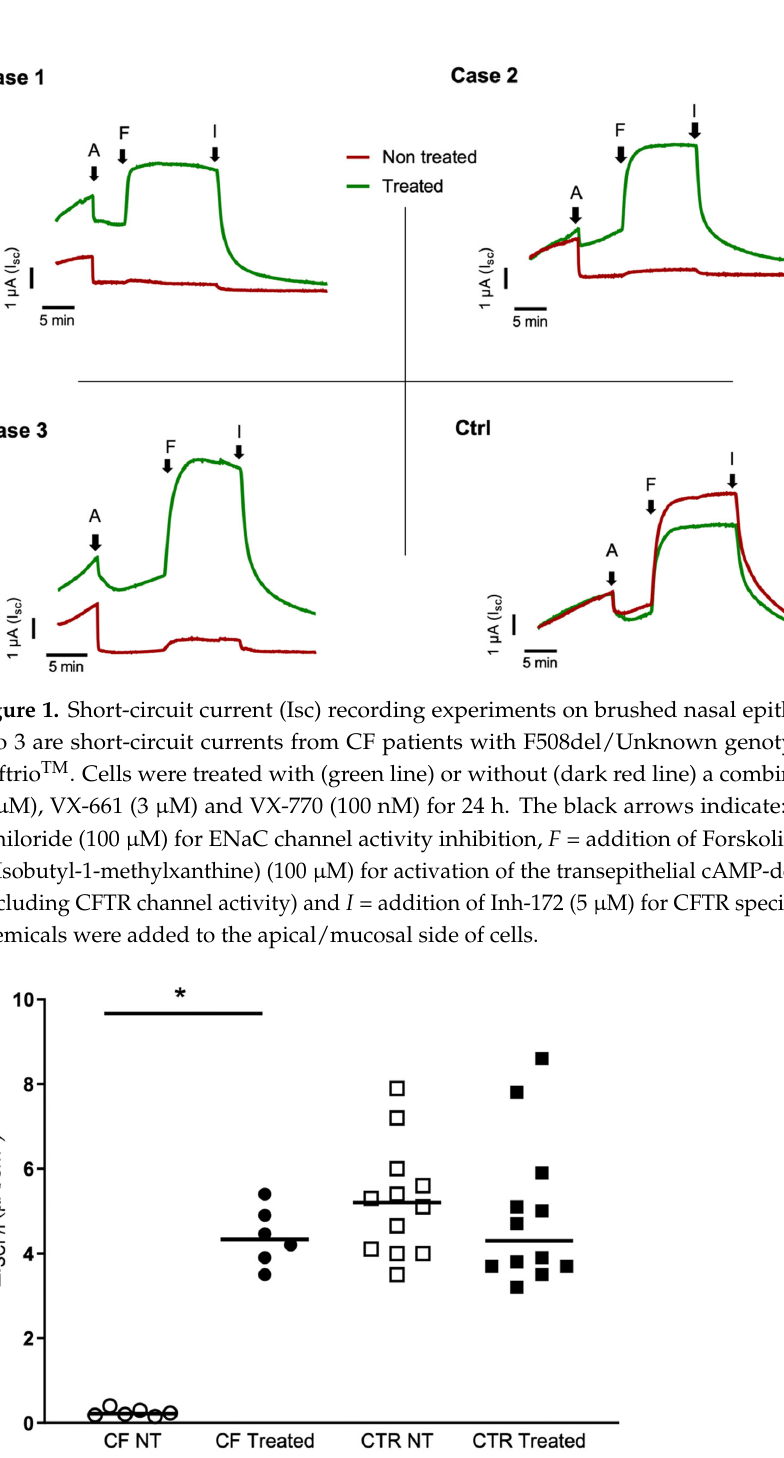
Figure 2. Kaftrio TM effect on CFTR ‐ dependent Cl ‐ secretion. Isc response to FSK Forskolin (10 μ M), IBMX (100 μ M) ( Δ IscF/I) after treatment for 24h with DMSO (No ‐ treated) or a combination of VX ‐ 445 (3 μ M), VX ‐ 661 (3 μ M) and VX ‐ 770 (100 nM) (Treated). Δ I scF/I recording experiments on brushed nasal epithelial cells from CF patients (two filters per patients, n = 3) with F508del/Unknown genotype and control subjects (two filters per subject, n = 6). CF NT: Cystic Fibrosis patients Non Treated (white circles), CF Treated (black circles), CTR NT: Control subjects Non Treated (white squares), CTR Treated (black squares). The p ‐ values for statistically significant differences are indicated as * < 0.031. In the Table 2 are presented the statistical analysis of the samples analyzed. Table 2. Kaftrio TM effect on CFTR ‐ dependent Cl ‐ secretion in CF and NO ‐ CF nasal epithelial cells.